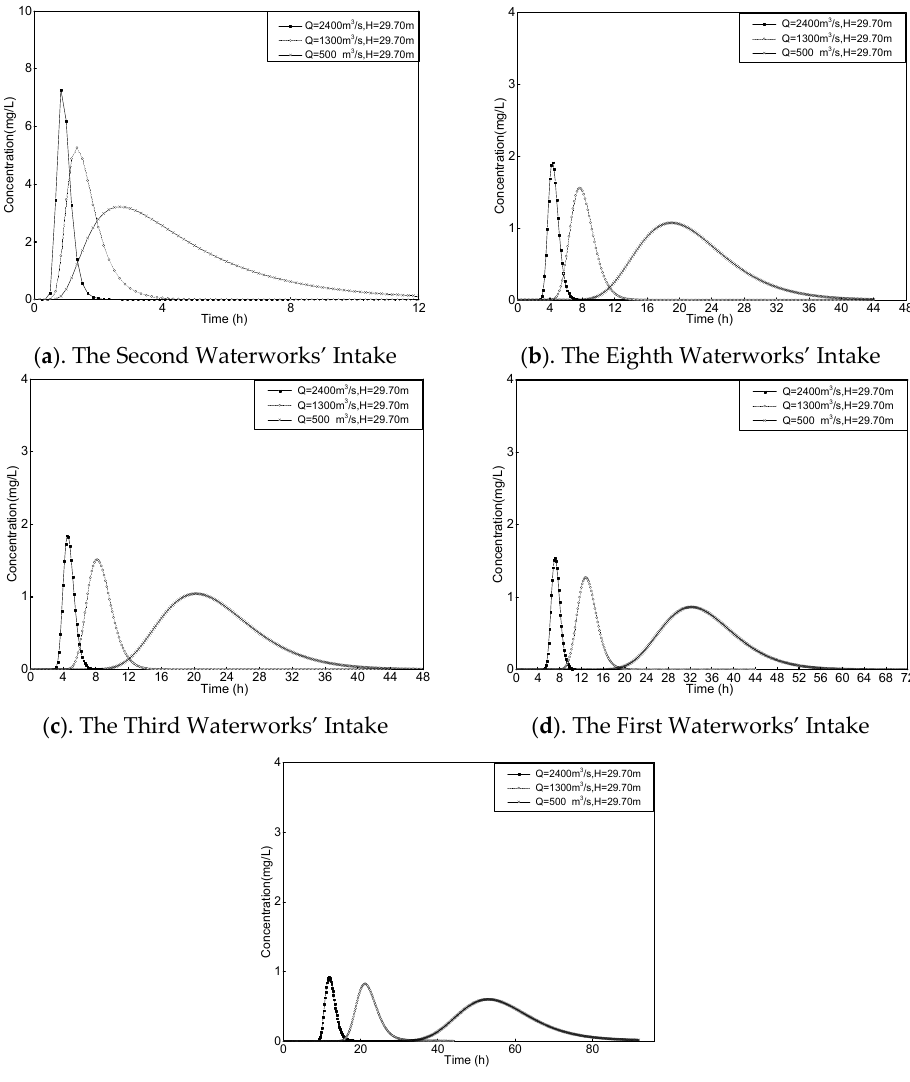
Figure 7. Pollutant concentrations with different discharges at different waterwork intakes along the Xiangjiang River under the scenarios with CCCP.